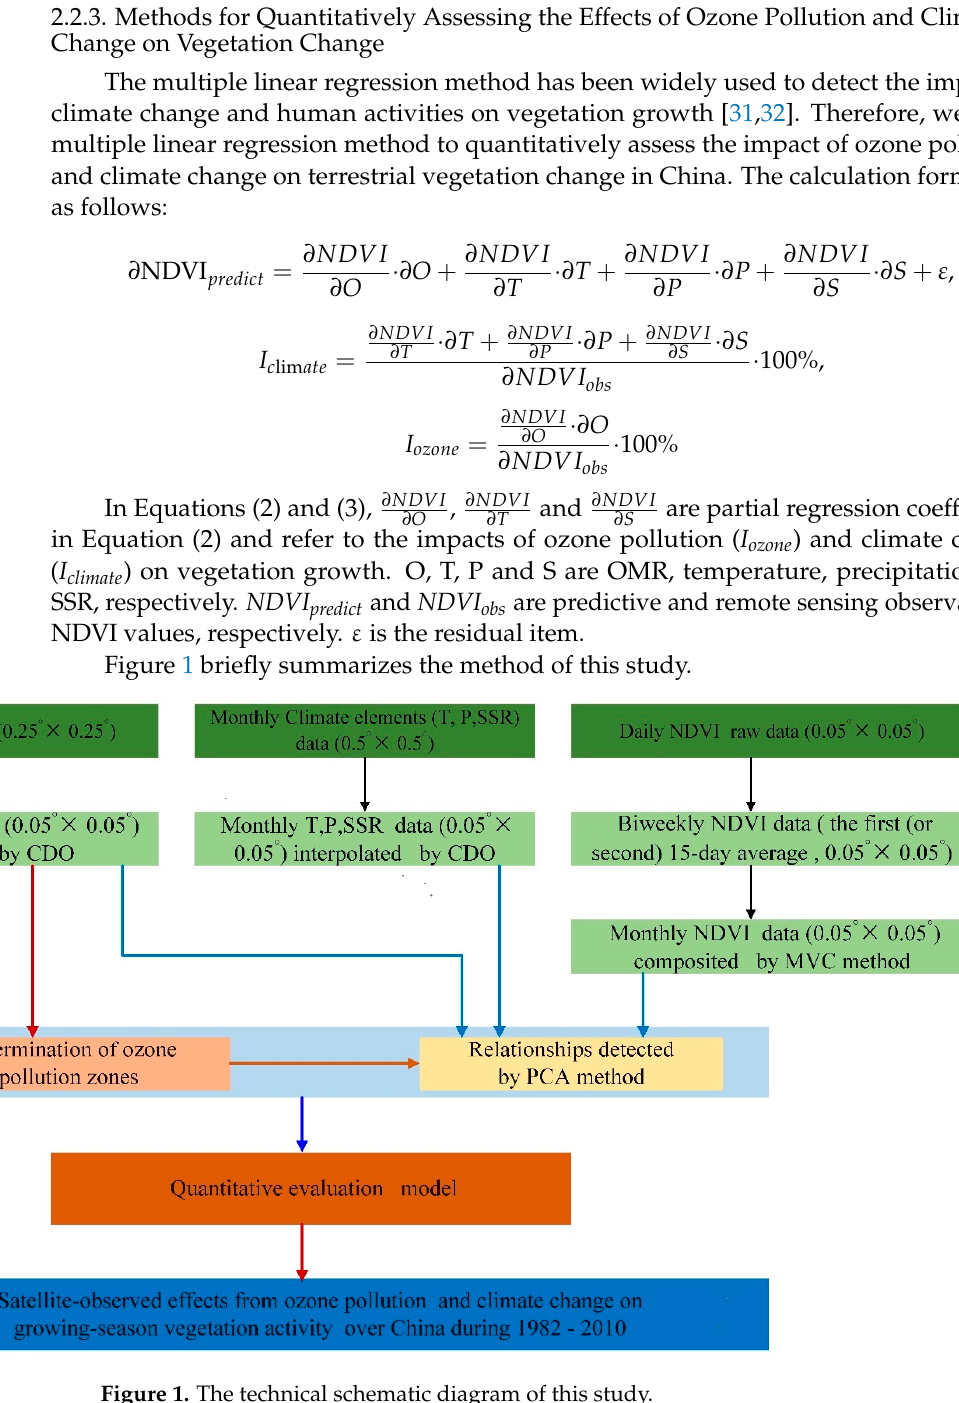
Figure 1. The technical schematic diagram of this